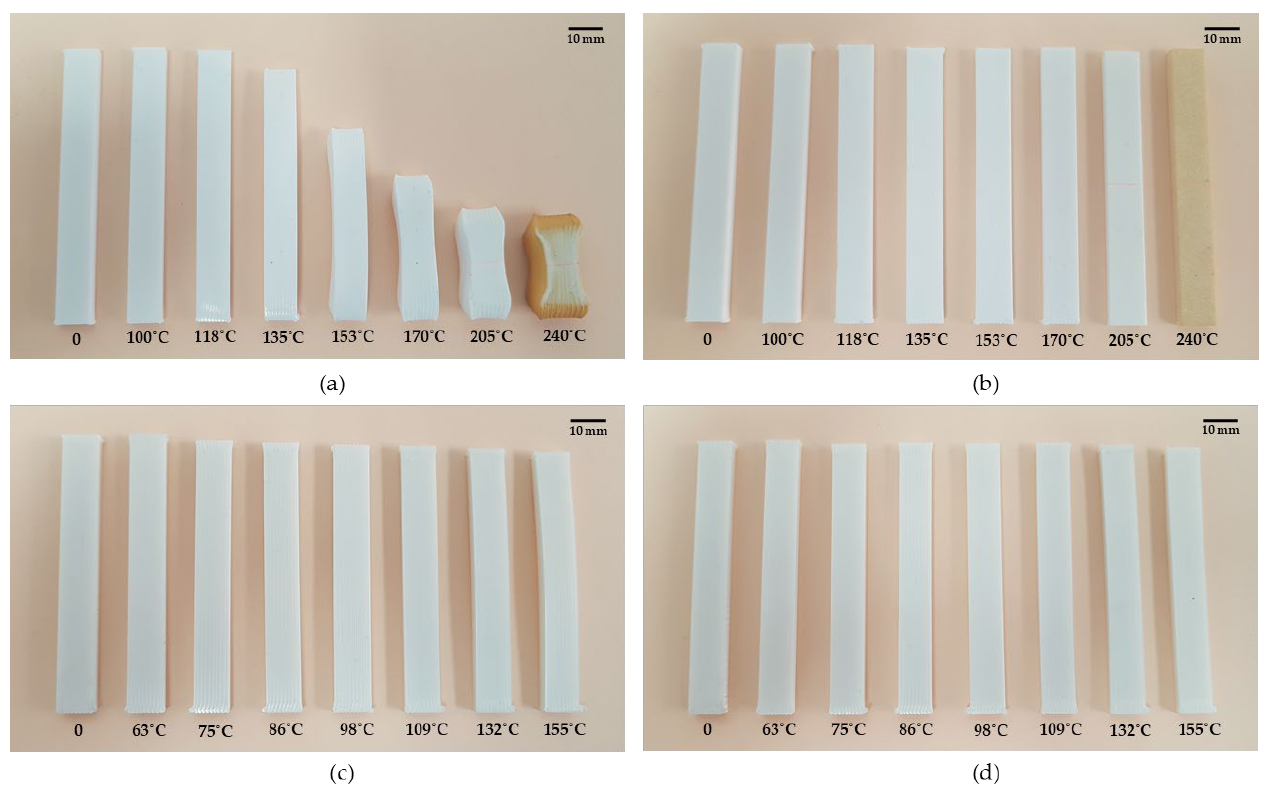
Figure 9. Sample comparison before thermal process (0) and after thermal process at seven annealing temperatures with mould and without mould: ( a ) ABS without mould samples; ( b ) ABS with mould samples; ( c ) PLA without mould samples; ( d ) PLA with mould samples.